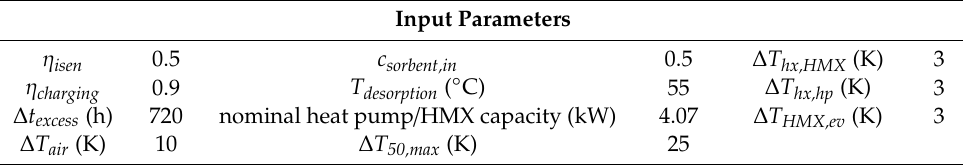
Table 2. Parameter values used for evaluation of energy flexibility provided with the building integrated sorption